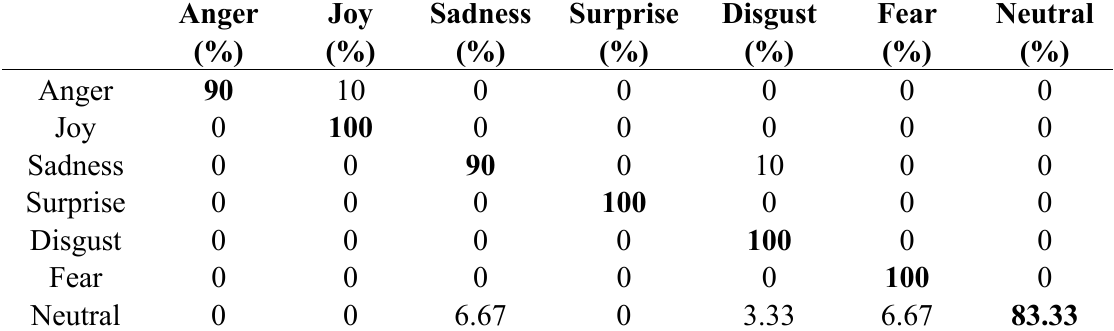
Table 3. Confusion matrix of recognition results of SRC with the raw